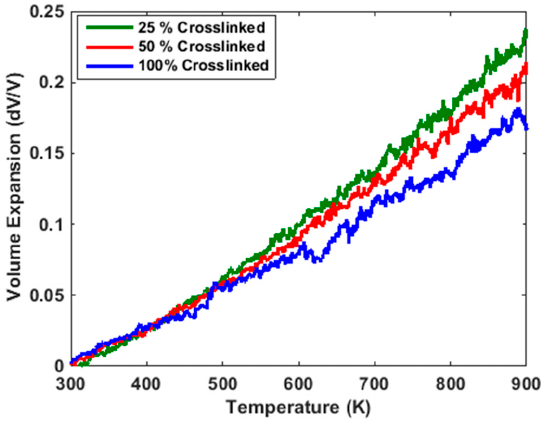
Figure 5. Volume expansion with respect to temperature for 25%, 50% and 100% crosslinked structures.